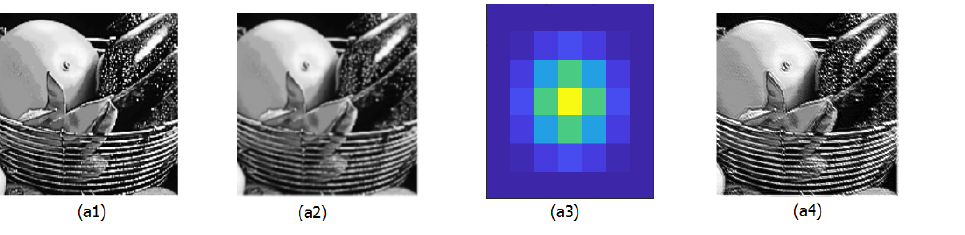
Figure 4. Original image ( a1 ); blurred image ( a2 ); Gaussian-(1,1) point-spread function ( a3 ) (colors denote different filter values); and deblurred image obtained by the exponentiated-gradient learning algorithm ( a4